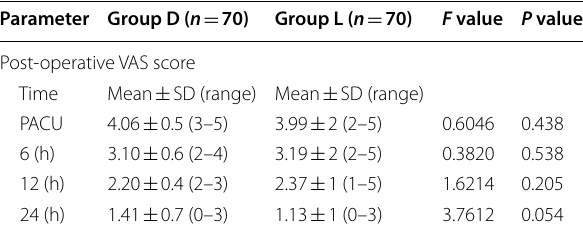
Values are expressed as mean